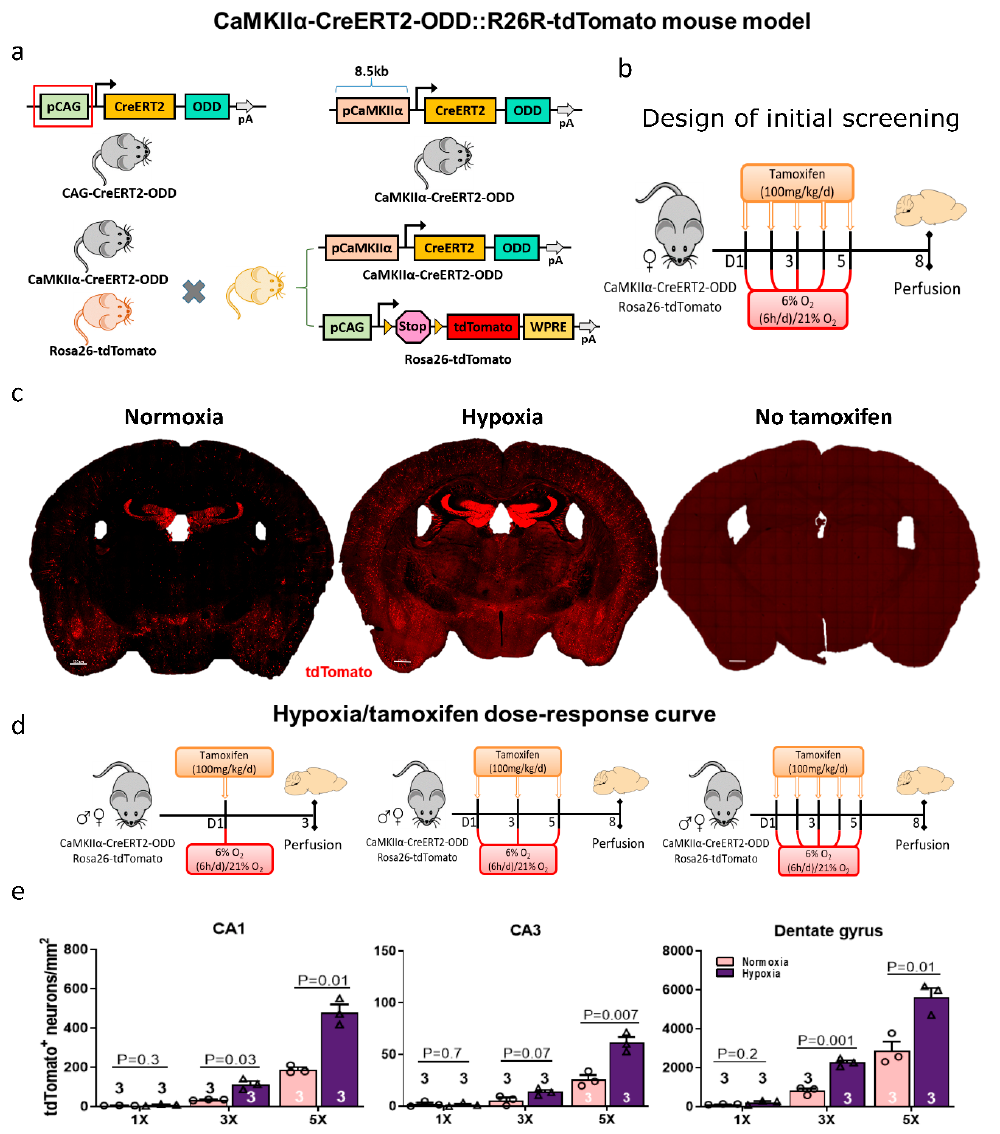
Figure 1. Generation and first characterization of excitatory neuron-specific CaMKII α -CreERT2-ODD::R26R-tdTomato hypoxia reporter mice. ( a ) Schematic representation of the CAG-CreERT2-ODD construct where the CAG promoter was excised using SpeI and EcoRI restriction enzymes to obtain the vector backbone (CreERT2-ODD-pA). Subsequently, the excitatory neuronal promotor CaMKII α of 8.5 kb was inserted into CreERT2-ODD-pA to generate the CaMKII α -CreERT2- ODD-pA vector. Next, the linearized vector was used for the generation of CaMKII α -CreERT2-ODD expressing transgenic mice. These were crossed with CAG-Rosa26-tdTomato reporter mice. Permanent labelling of hypoxic neurons is achieved via Hif-1 α oxygen-dependent degradation domain (ODD) stabilization upon tamoxifen injection. ( b ) Experimental design: For an initial screening, CaMKII α -CreERT2-ODD::R26R-tdTomato hypoxia reporter mice received tamoxifen five times over five days, each time followed by exogenous hypoxia (6% O 2 for 6 h) versus normoxia (21% O 2 ), and mice were sacrificed on day eight. ( c ) Representative coronal images of five-times tamoxifen-injected CaMKII α -CreERT2- ODD::R26R-tdTomato mice under normoxic or hypoxic conditions. The corn oil control (‘no tamoxifen’) shows only very few tdTomato+ (red) neurons, i.e., minimal tamoxifen-independent Cre-activity. Scale bar represents 500 µm. ( d ) Experimental scheme of the hypoxia/tamoxifen dose response curve in CaMKII α -CreERT2-ODD::R26R-tdTomato mice. ( e ) Quantification of tdTomato+Ctip2+ double-positive neurons in CA1, CA3 and dentate gyrus from eight-week-old mice of equally distributed mixed gender. Unpaired Student’s t -test (two-tailed, Welch’s corrections) was used for statistical analysis between groups; n numbers given in graphs; error bars indicate standard error of mean (SEM).